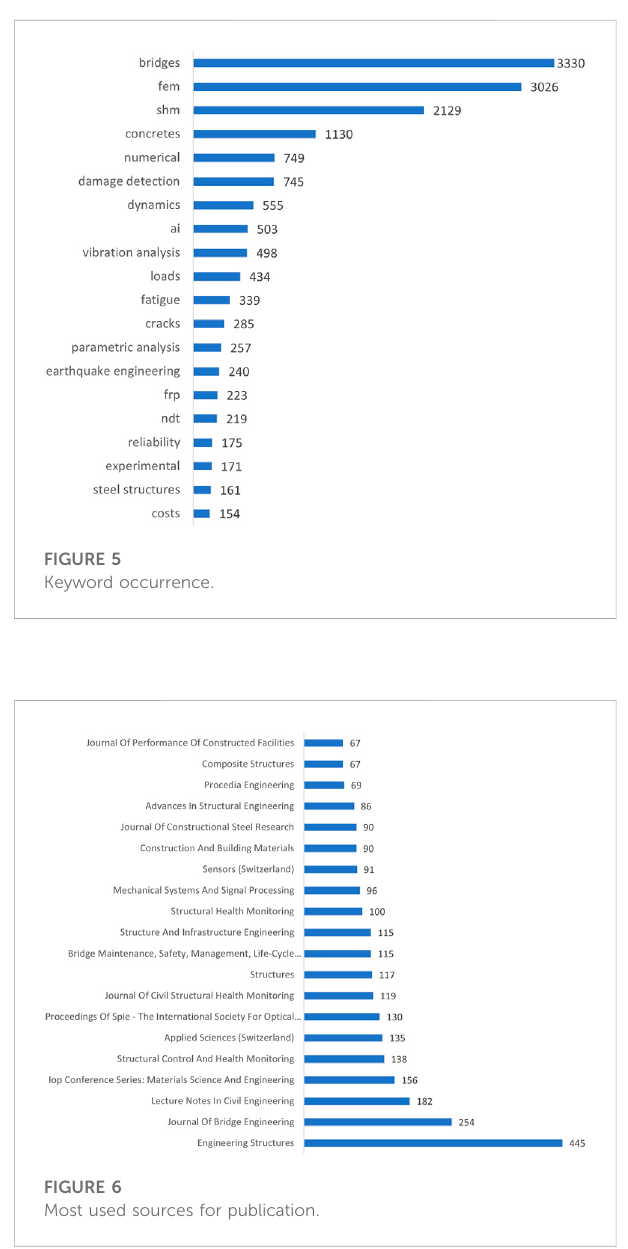
FIGURE 6 Most used sources for publication.